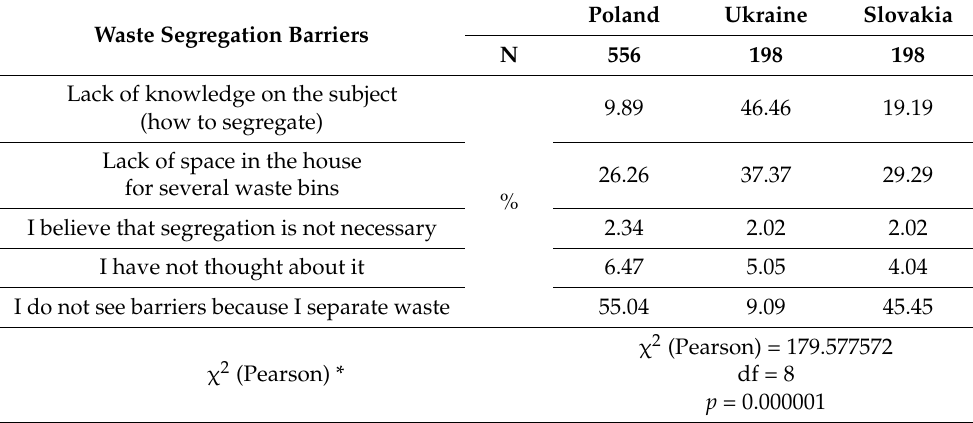
Table 11. Barriers preventing waste segregation according to respondents from Poland, Ukraine and Slovakia.